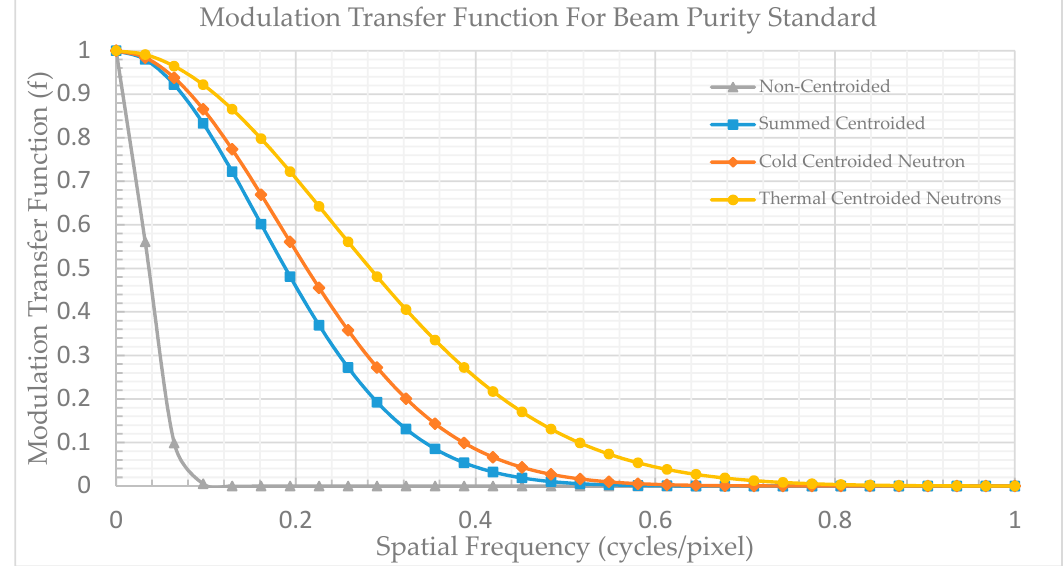
Figure 12. Modulation Transfer Function plots for non-centroided, centroided cold, thermal, and non-energy resolved centroided radiographs.